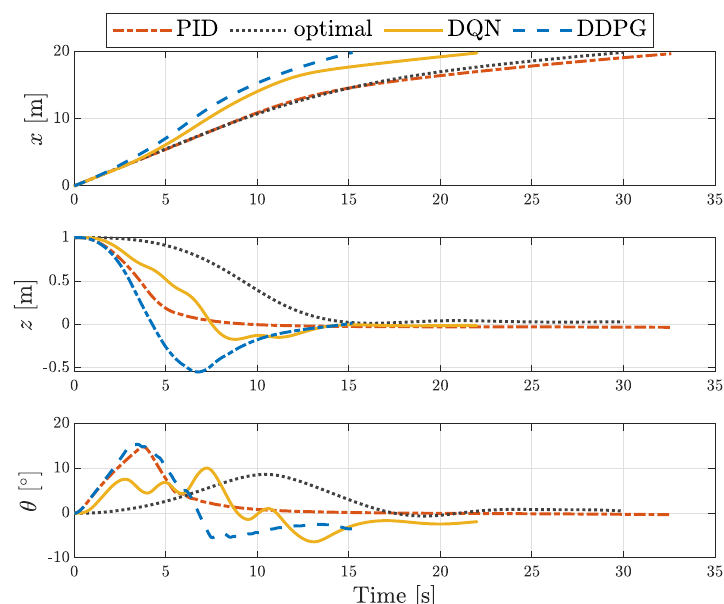
Figure 9. Translation and rotation of the AUV during docking with different control strategies.